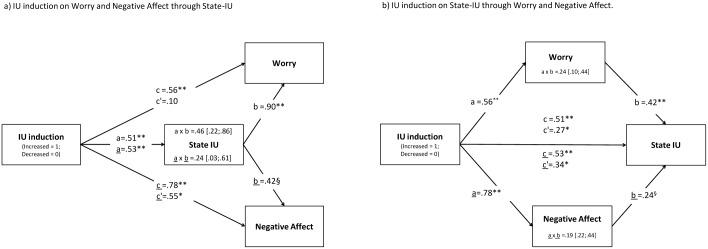
Mediation analysis.